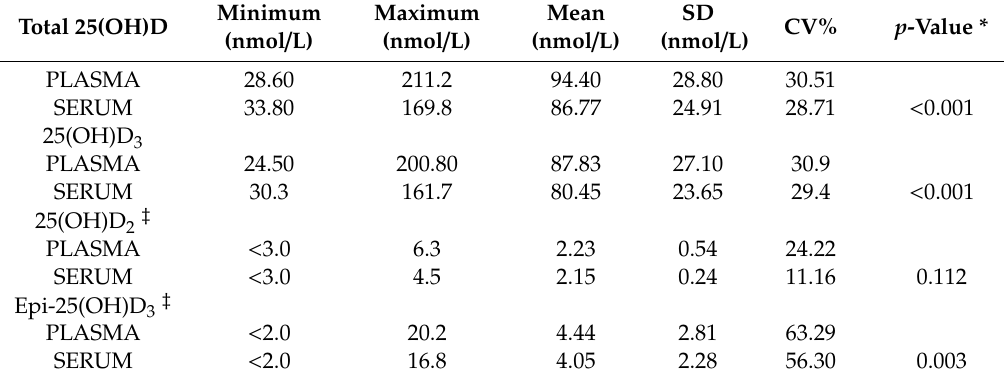
Table 1. Mean, range, standard deviation and coe ffi cient of variation for n = 114 matched serum and plasma samples collected from pregnant women.